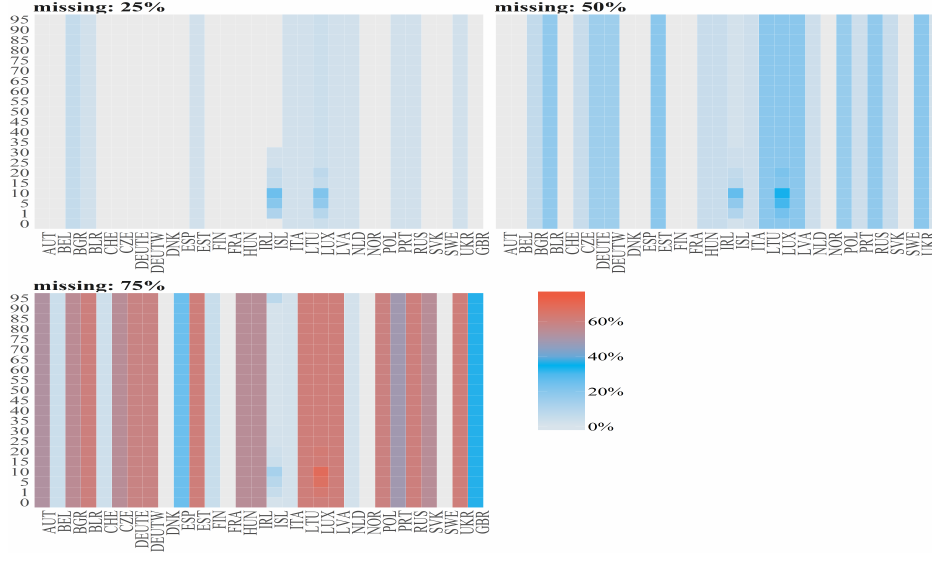
Figure 6. Percentages of missing values (denoted by diffrent colours) for Number of Deaths for Males per country (x axis) and age group (y axis). The titles of the subplots indicate the case of missing values (25%, 50%, 75%). The percentage of missing values for a given country and an age group is calculated dividing number of missing values by length of subsample which is different for different